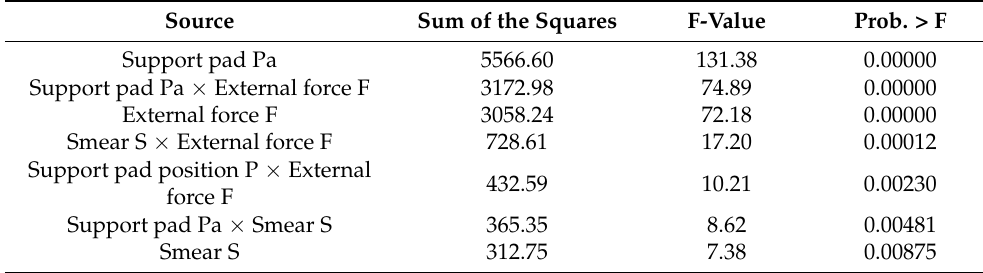
Table 9. Factors and interactions having a statistically significant influence on total support pad